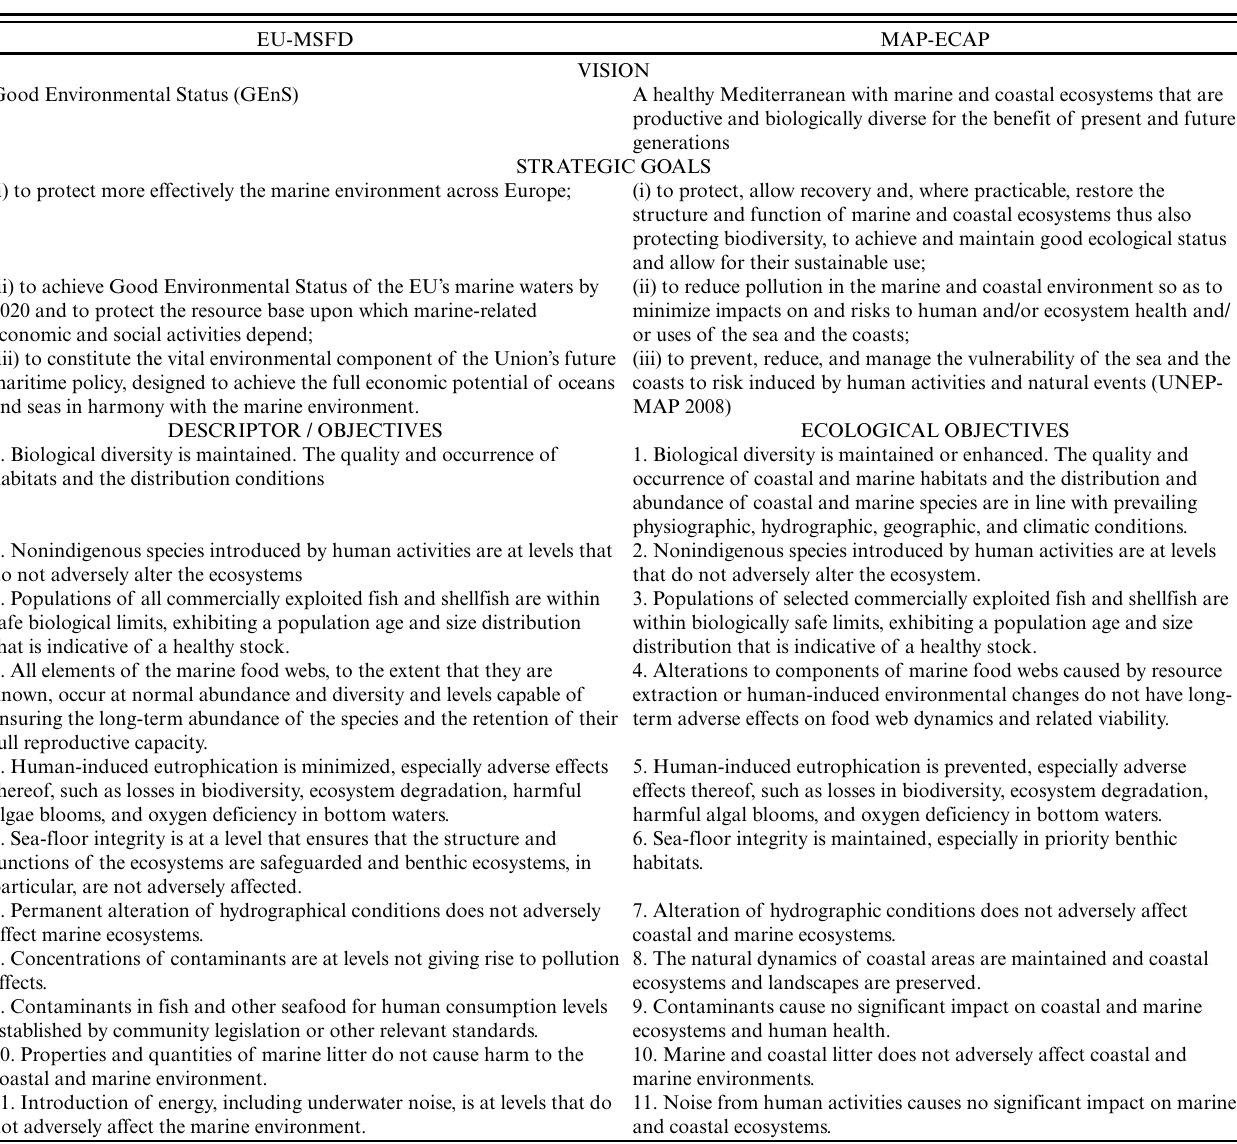
Table 3. Comparison between EU-Marine Strategy Framework Directive (MSFD) and Mediterranean Action Plan-Ecosystem Approach Strategy (MAP-ECAP) vision, strategic goals, and ecological objectives already defined. With the exception of